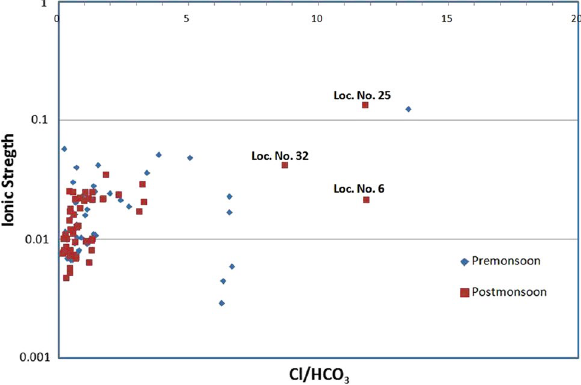
Fig. 8 Relationship between Mg/Ca and Cl/HCO groundwater